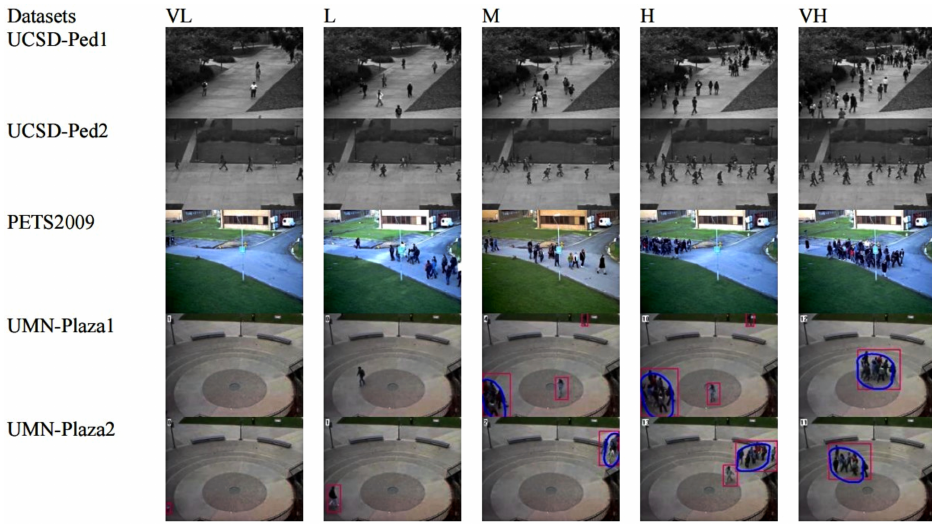
Figure 4. Examples of crowd scene of different density